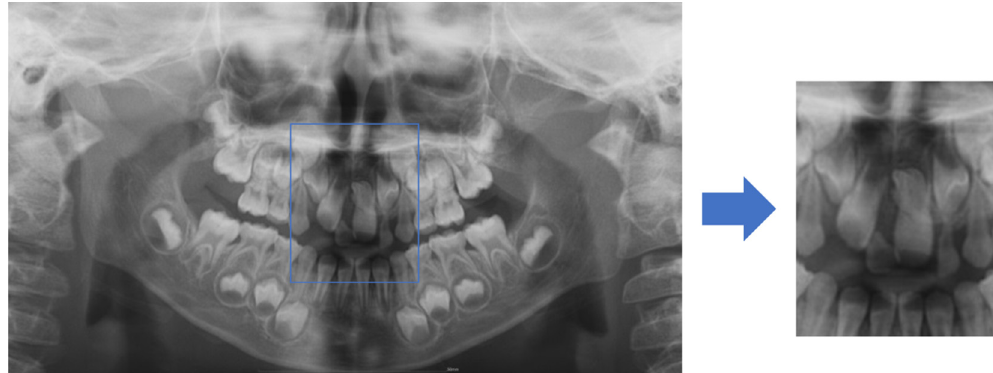
Figure 1. Region of interest (ROI). Images were cropped, as shown in blue box, based on the distal and uppermost points of both permanent canine tooth germs and mandibular anterior alveolar bone level.